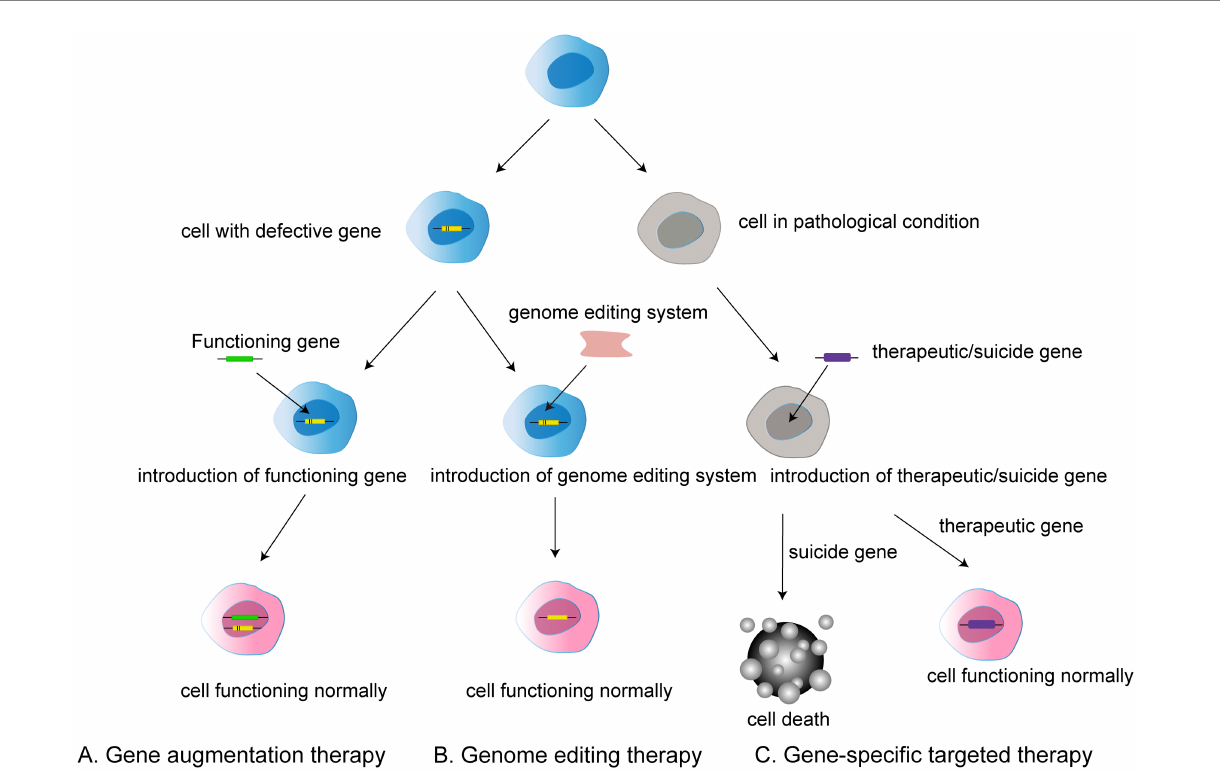
FIGURE 1 Three types of gene therapy: (A) Gene augmentation therapy involves introducing a functional gene into a cell that has a defective gene in order to allow the cell to function normally. (B) Gene editing therapy refers to the use of gene editing system to modify faulty genes into normal functioning cells. (C) Gene-specific targeted therapy refers to the introduction of therapeutic or suicide cells into a target cell with a disease condition to induce either death or normal